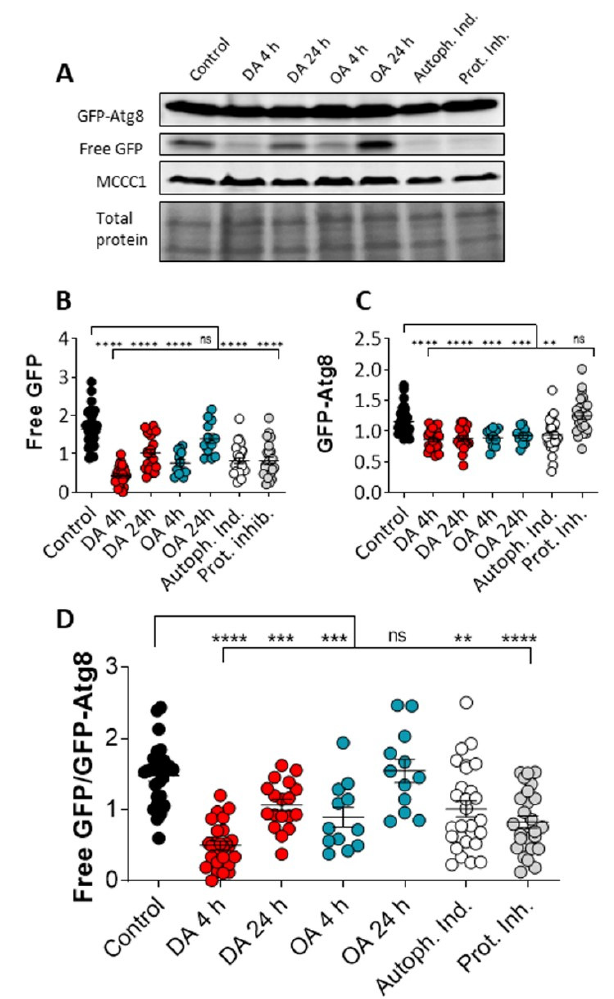
Figure 2. Decanoic acid enhances autophagic flux in Dictyostelium . Autophagic flux can be measured in Dictyostelium cells expressing GFP-Atg8 by western blot using a GFP-specific antibody to visualise total GFP-Atg8, cleavage to free GFP, and proteolytic degradation of free GFP, with MCCC1 as a loading control, and additionally visualized with total protein. Autophagic flux was analyzed in Dictyostelium cells, under control conditions (solvent-treated growing cells), or cells treated with decanoic acid (DA) or octanoic acid (OA), both at 60 μ M, for 4 or 24 h, or with an autophagy inducer or protease inhibitor, showing ( A ) a representative western blot of GFP-Atg8, Free GFP, and loading control (MCCC1), and total protein levels. Quantification of ( B ) GFP-Atg8 and ( C ) free GFP levels, enabled the assessment of autophagic flux provided by ( D ) the ratio of free GFP:GFP-Atg8. Data, analyzed by a Kruskal–Wallis with Dunn’s multiple comparisons test, from n = 8, provides significance indicated by ns p > 0.05, ** p ≤ 0.01, *** p ≤ 0.001, and **** p ≤ 0.0001.